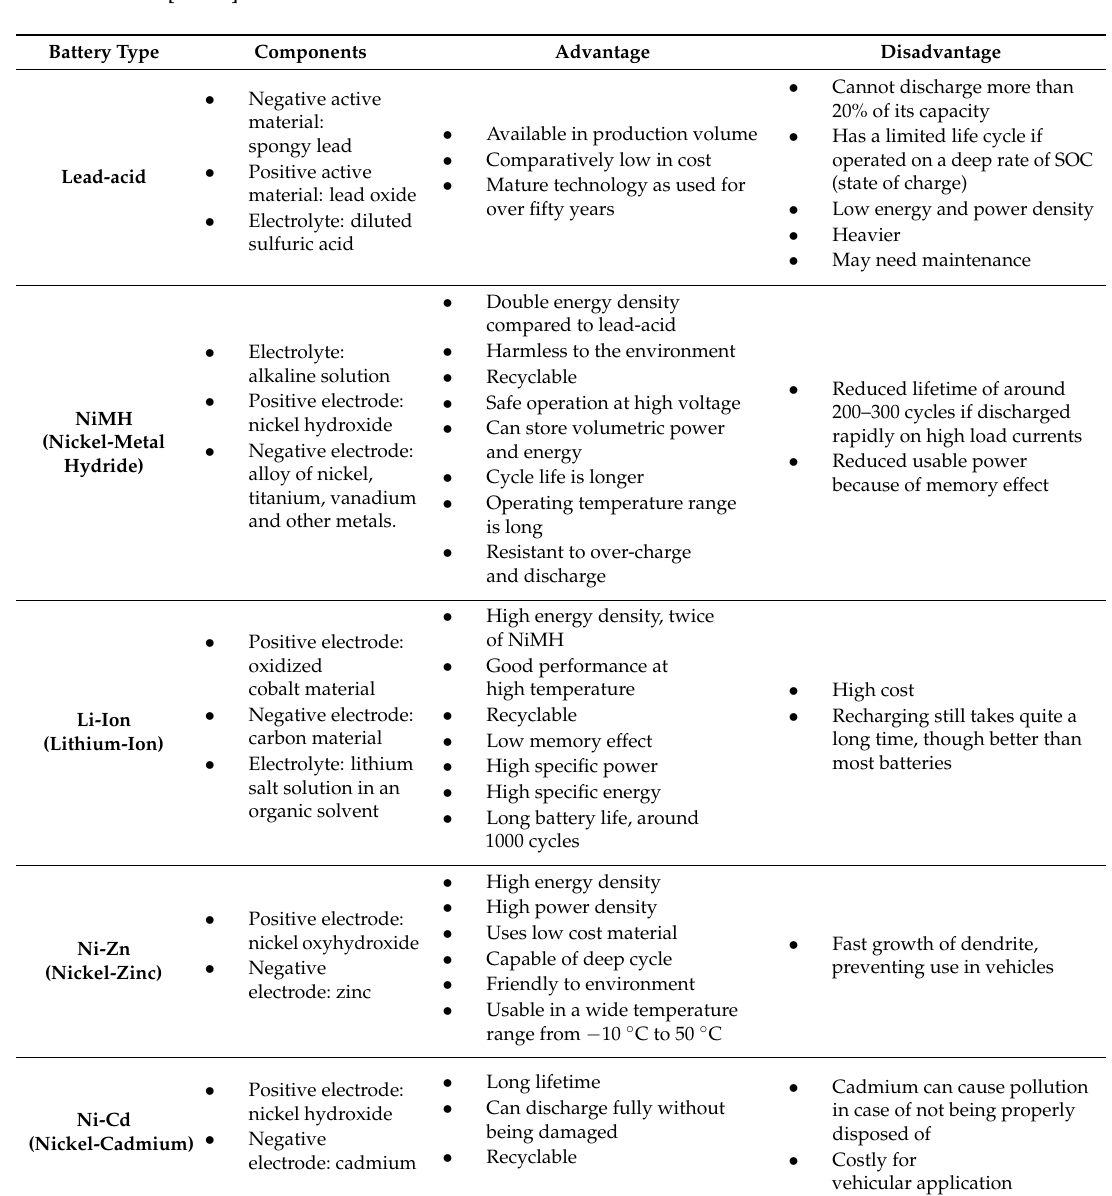
Table 6. Common battery types, their basic construction components, advantages and disadvantages. Data from